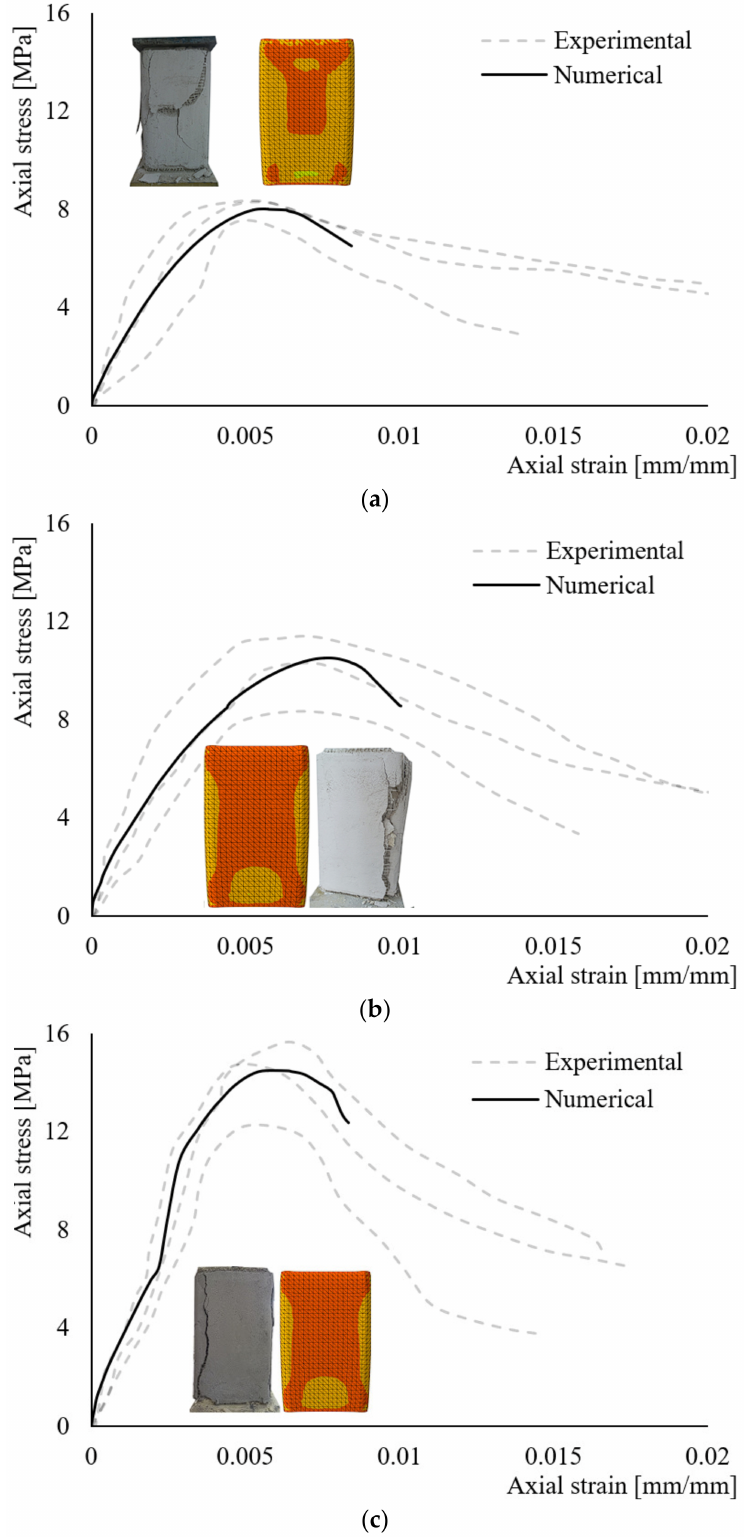
Figure 11. Comparison results for reinforced column between the numerical and average experimen- tal curve reported in Cascardi et al. [65]: ( a ) FRCM_M4, ( b ) FRCM_M7, and ( c ) FRCM_M23. In Table 8, the error evaluated by Equation (19) is summarized. In Figure 11, the crack pattern at failure is also reported and is compared to that observed